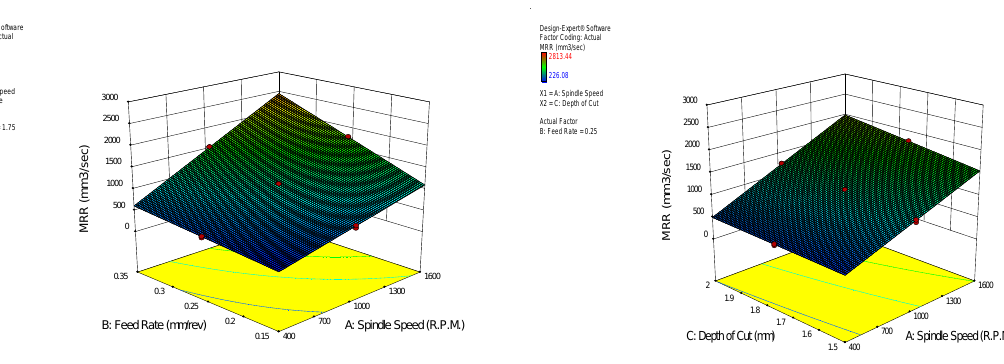
Fig. 11. Influence of Depth of cut & Spindle speed on